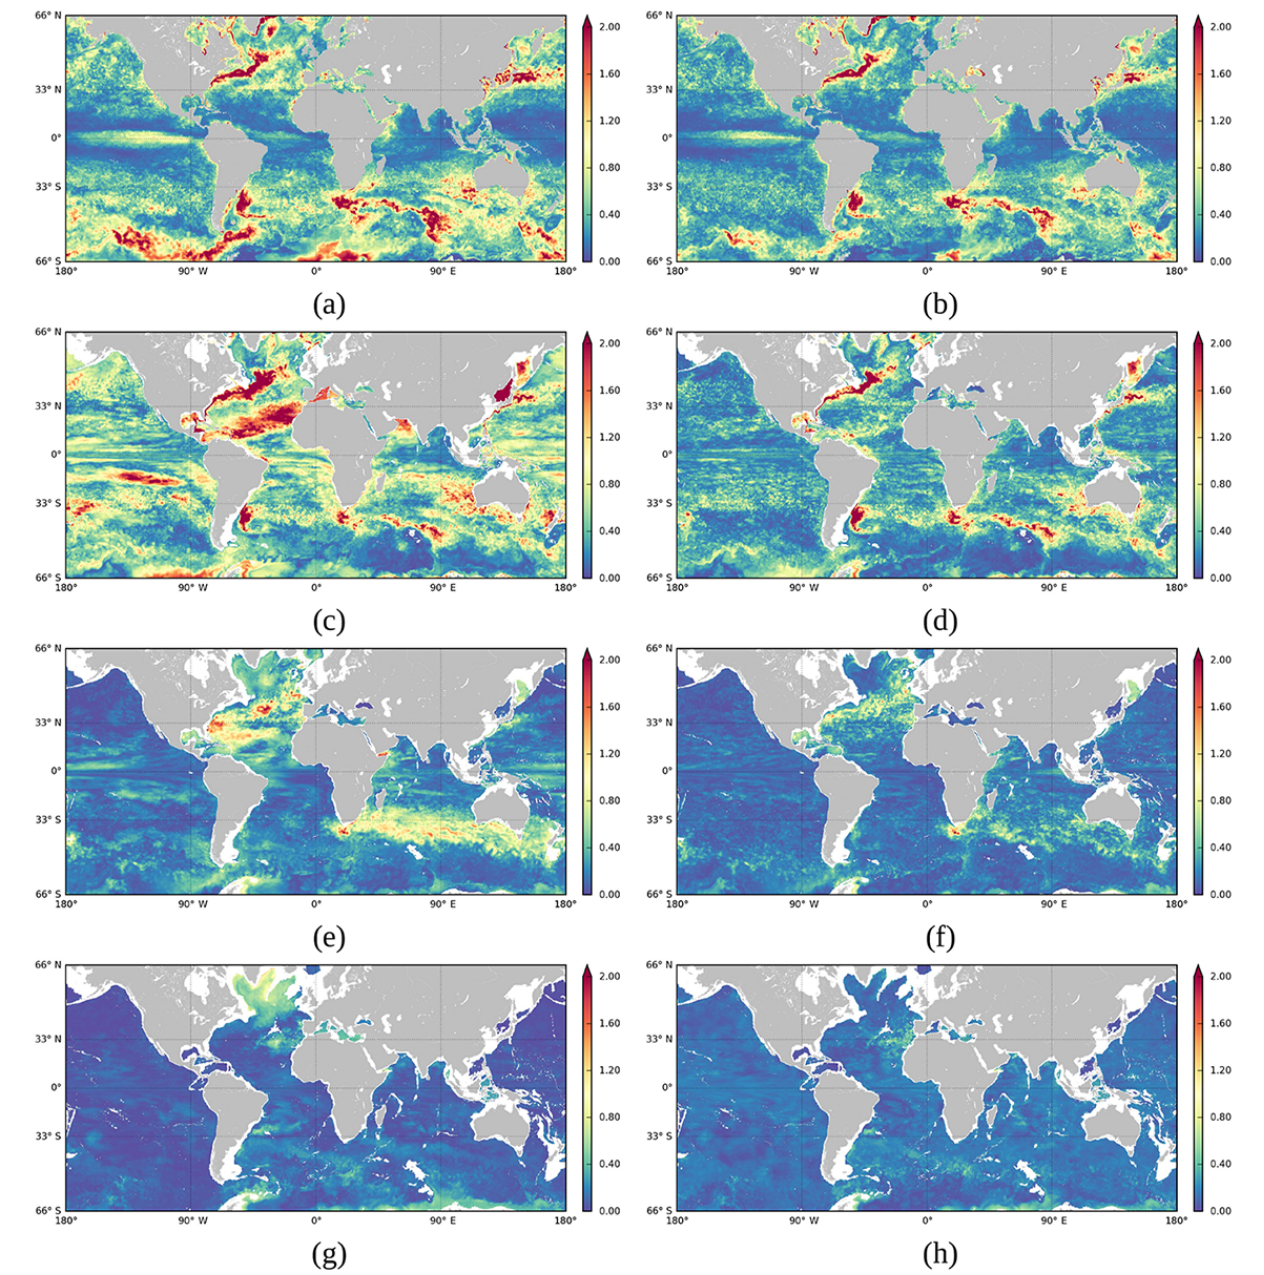
Figure 16. Global 7-day forecast RMSE of T in ◦ C for Sat3 (left) and Argo1 (right) at the surface (a, b) , 318m (c, d) , 902m (e, f) and 1941m (g, h)